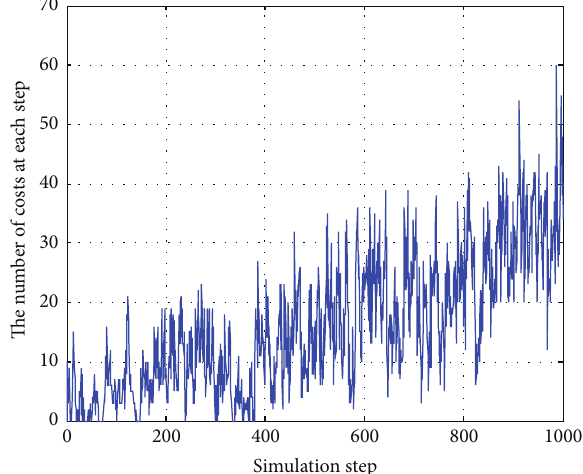
Figure 9: The number of costs at each step.